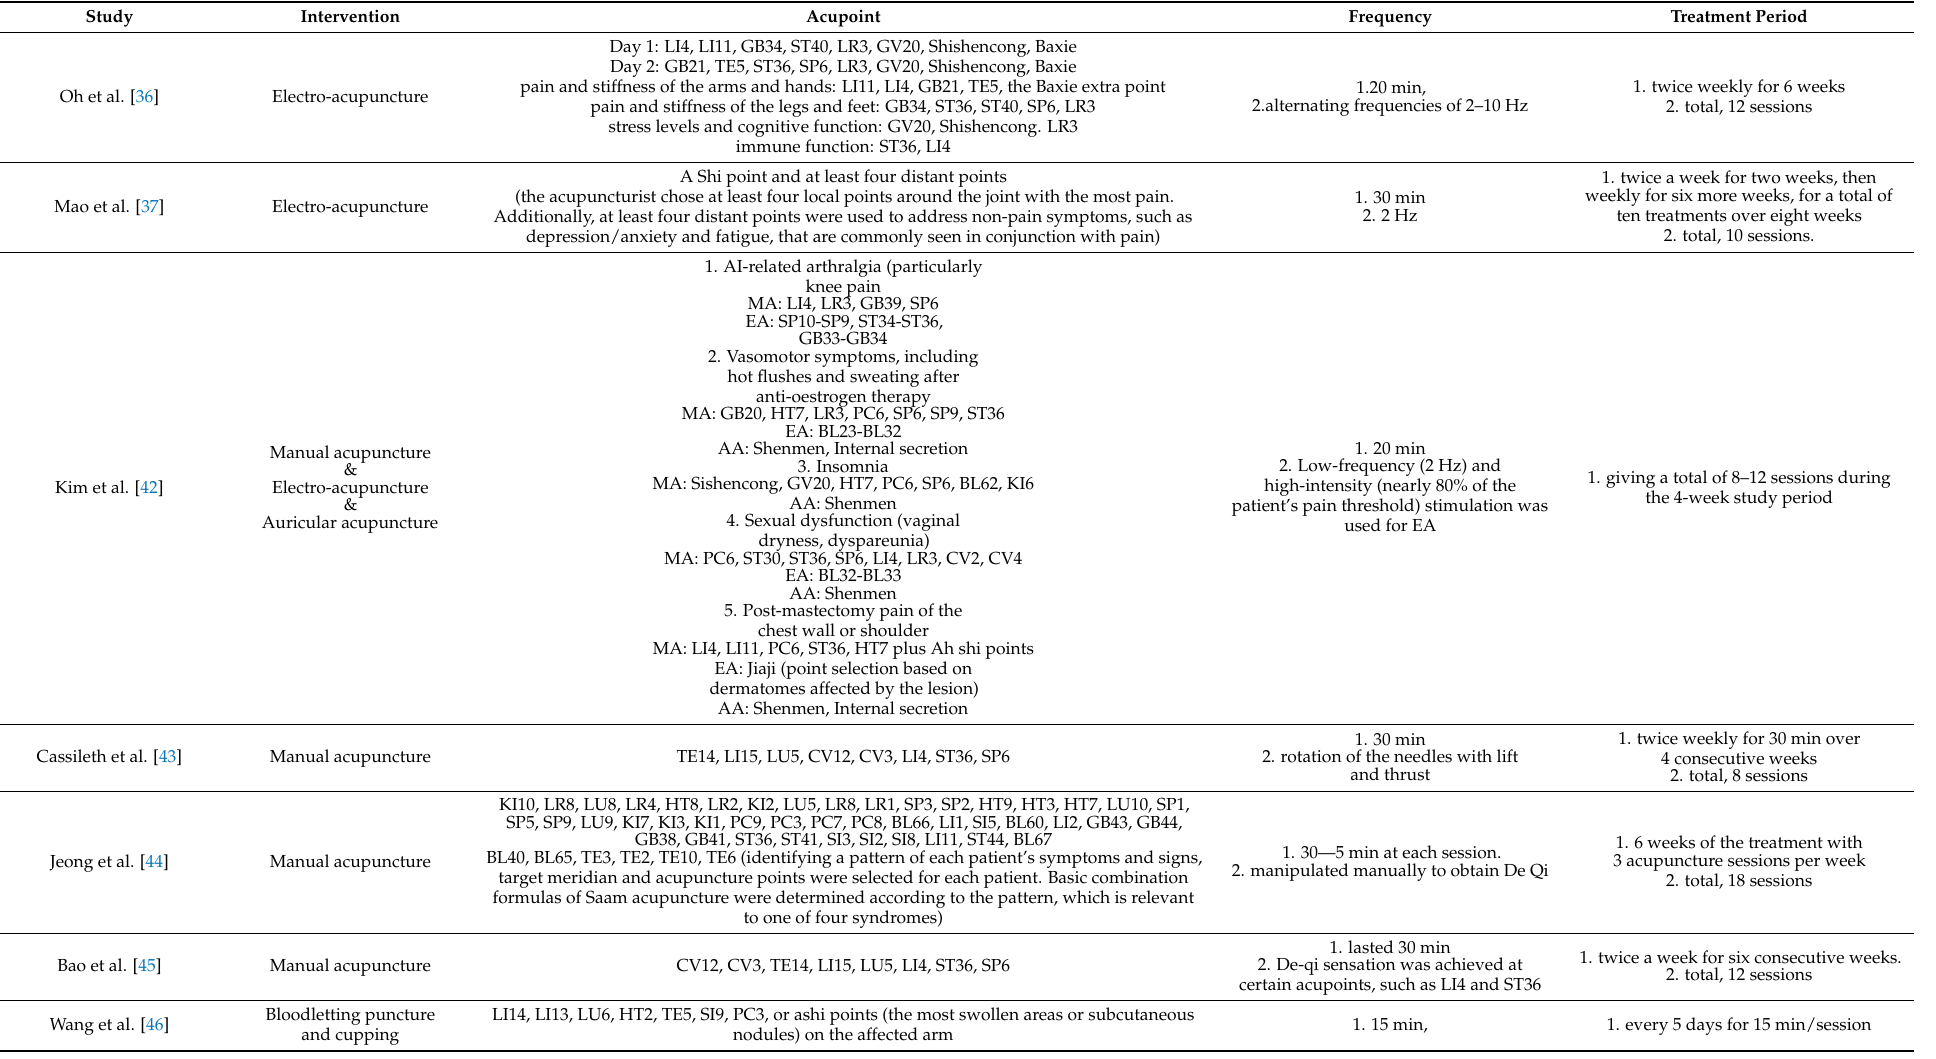
Table 6. Summary of the intervention (acupuncture-related therapies) in the included